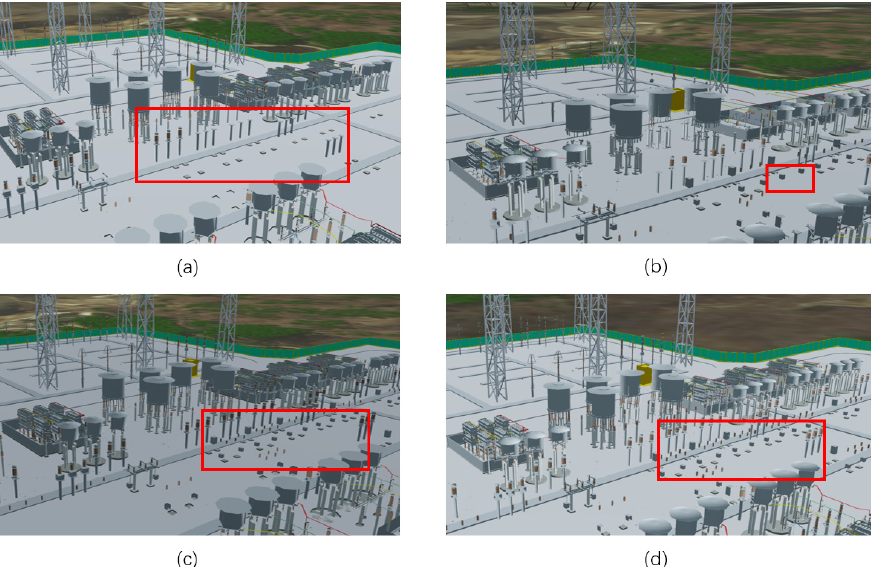
Figure 10. Model visualization at a viewing distance of 50 m when using: ( a ) proposed method, ( b ) Method 1, ( c ) Method 2, and ( d ) Method 3. ( b ) Method 1, ( c ) Method 2, and ( d ) Method